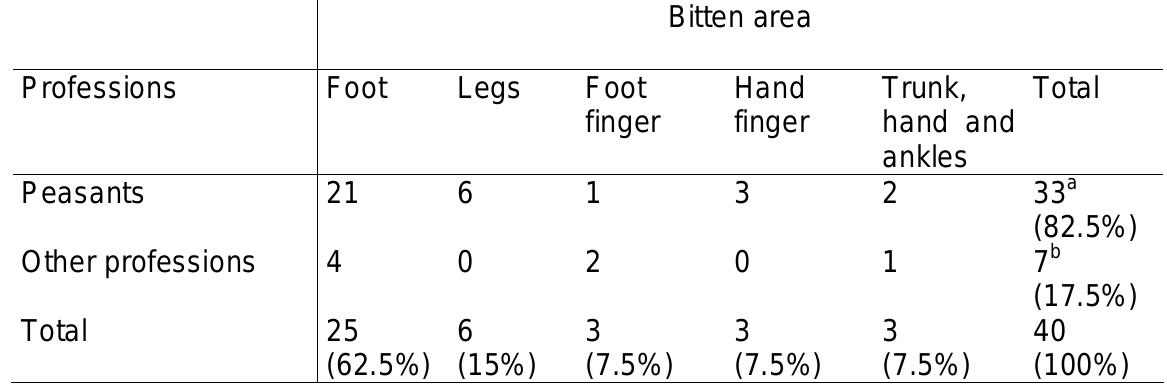
Table 3: Frequency of envenomations in the Northwest counties of the Rio de Janeiro State, Brazil, in 1995, 1996 and 2000, according to profession and injured anatomical